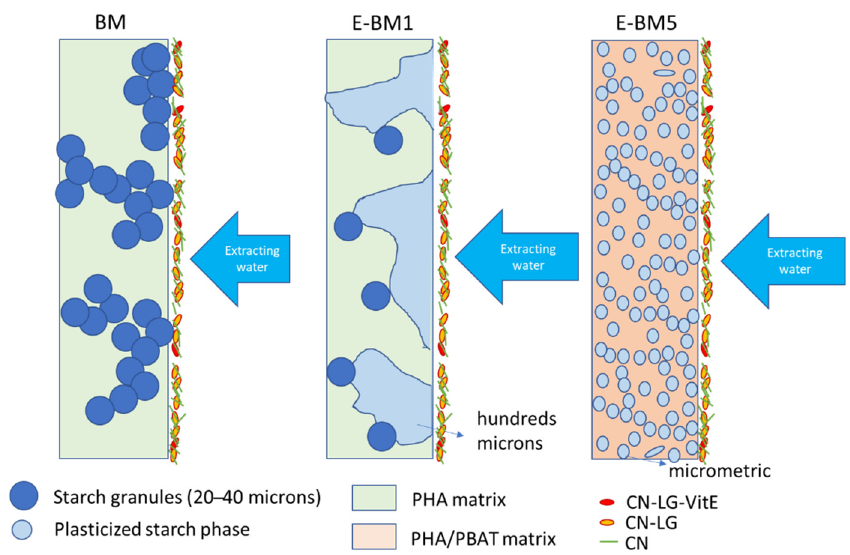
Figure 9. Scheme considering the different species and morphologies of the three potential models of beauty masks for explaining the results of release tests in water.